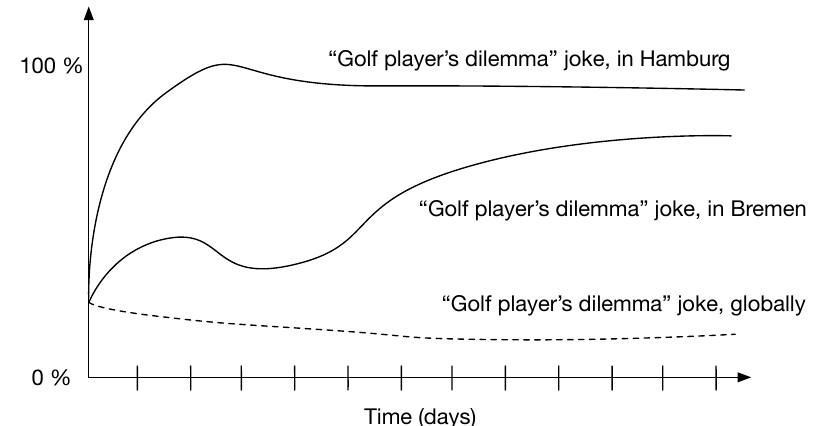
Figure 2. Development of popularity of a joke over time. While the joke is very popular in Hamburg, it is less popular in Bremen and not popular